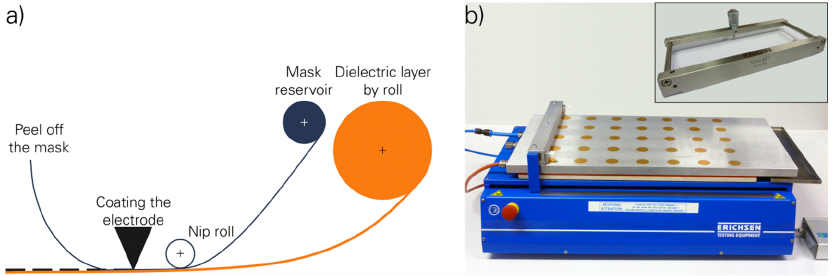
Figure 4. ( a ) Fabrication process for the DEA (method 2) [15]; and ( b ) the COATMASTER 509 MC and the MULTCATOR 411.